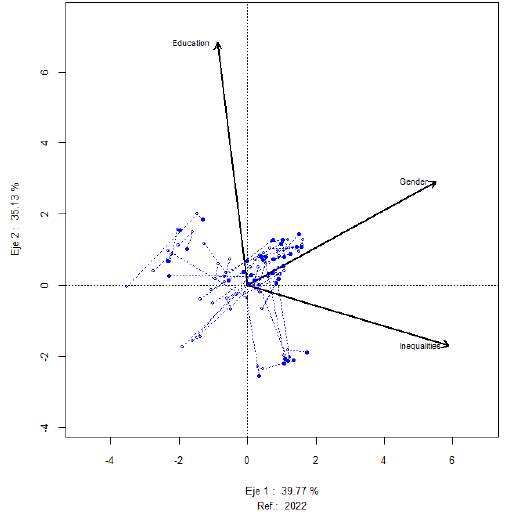
Figure 4. Dynamic biplot factorial representation of THE Impact Rankings (universities), plane 1–2. The points of the figure represent the universities, the names have been omitted because the important thing is to observe their trajectories.